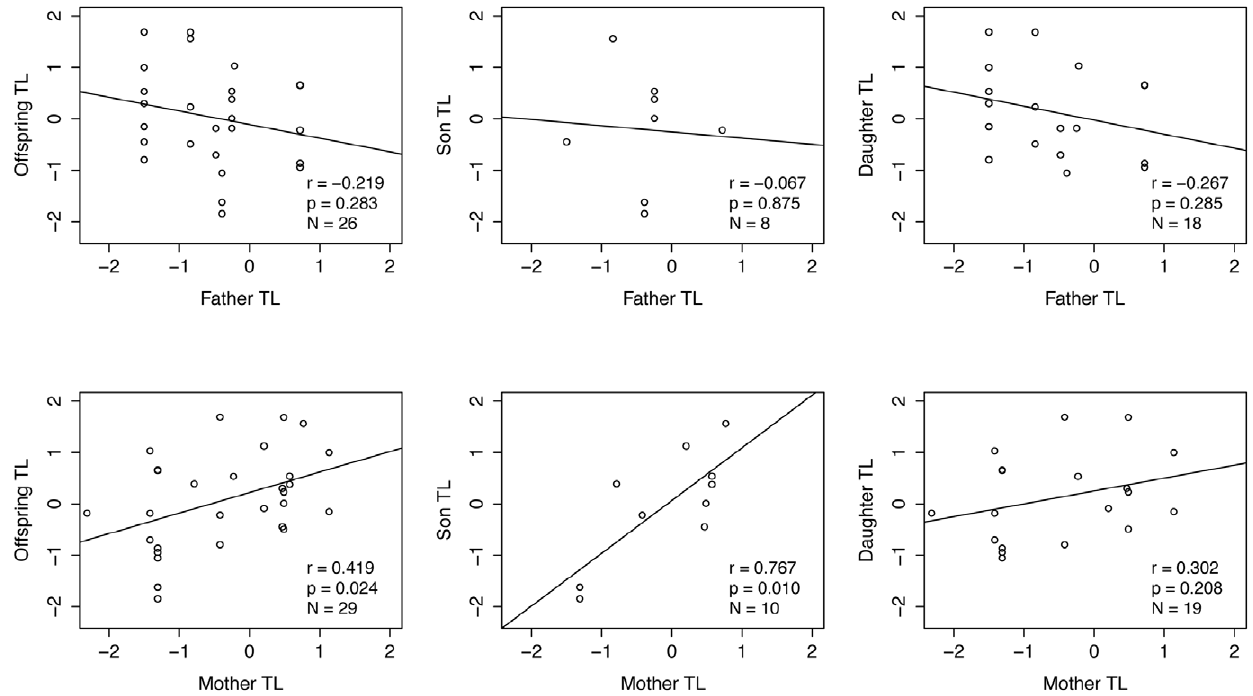
Figure 2. Parent-offspring correlations of kakapo telomere length corrected for sex. doi:10.1371/journal.pone.0017199.g002 PLoS ONE |